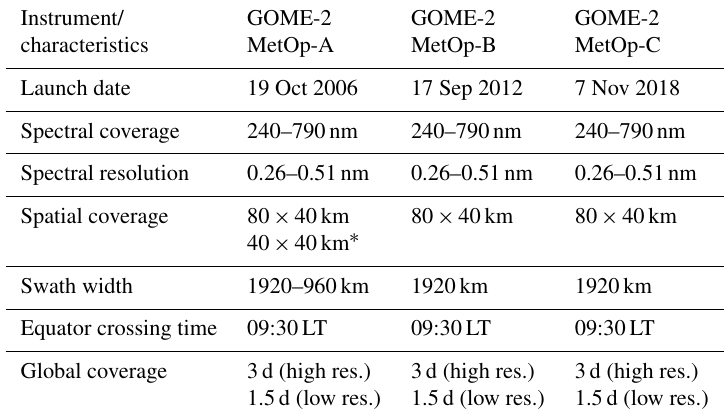
Table 1. Summary of the GOME-2 instrument main characteristics. The ∗ indicates GOME-2A tandem operation starting from 15 July